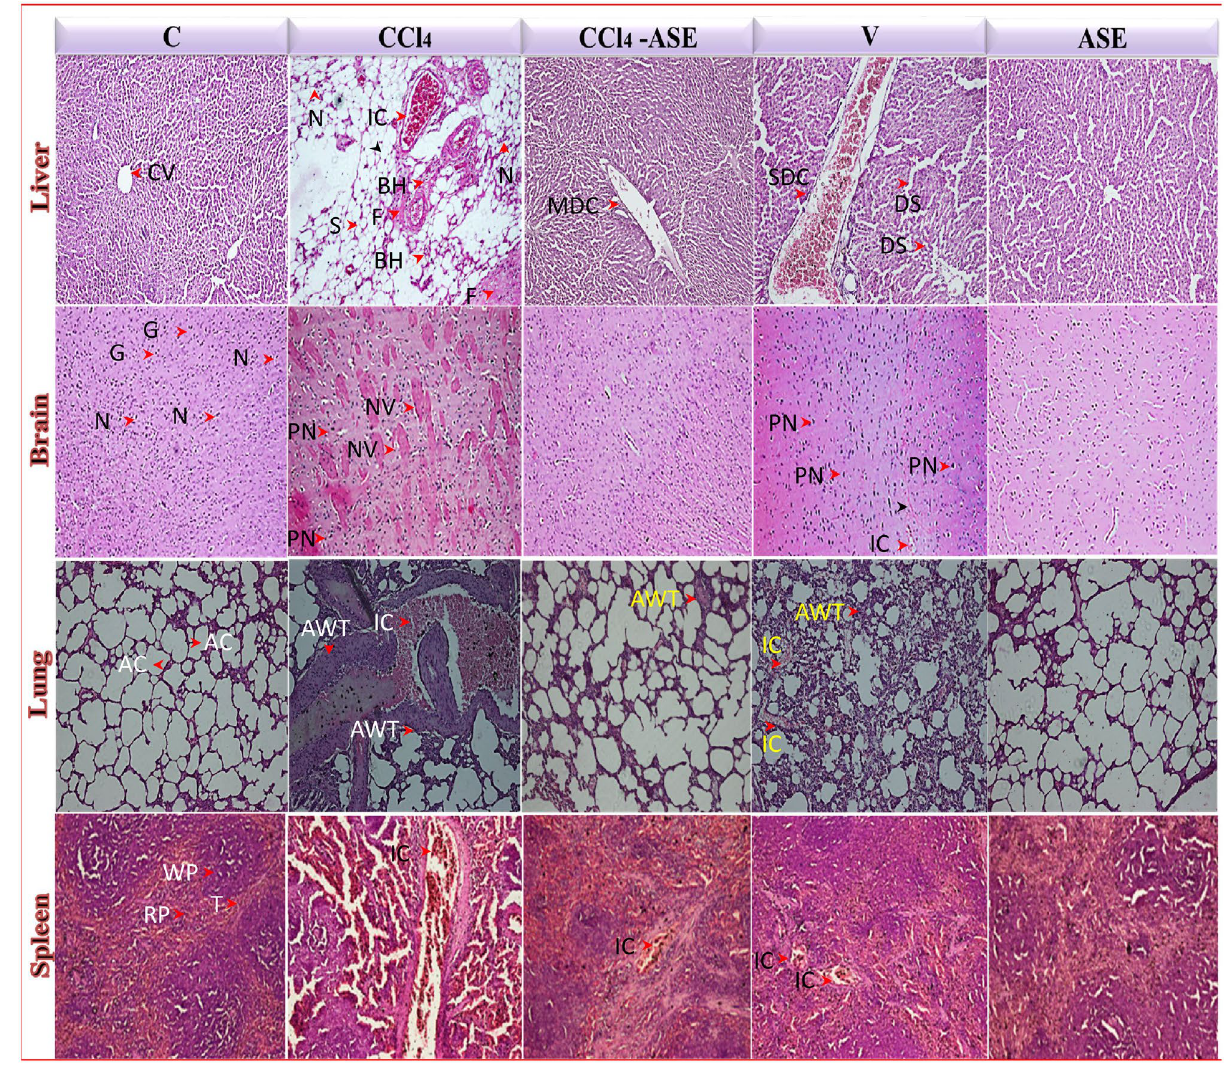
Figure 7. Photomicrographs (H&E stain, 20 ×) for liver, brain, lung, and spleen sections of the different studied groups revealed the ameliorating effects of ASE against the systemic toxicity induced by CCl 4 injection. AC alveolar cells, AWT : alveolar wall thickness, BH binucleated hepatocytes, CV central vein, DS dilation of sinusoidal cells, F fibrous bands, G glial cells, IC inflammatory cells, MDC mild dilation of central vein, N neurons, NV neurons with the vacuole, PN neurons with pyknotic nuclei, RP red pulp, SDC severe dilation of the central vein, S steatosis, T trabecula, WP white Regarding the brain, the control tissues showed normal architecture with normal glial cells and neurons. This normal morphology was changed after CCl 4 injection to severe damage with severe degeneration of neurons that was characterized by the appearance of pyknotic nuclei and vacuoles in the neuronal cells. Administration of ASE restored the architecture of the brain and relieved the CCl 4 toxicity. Injection of rats with olive oil (V group) caused mild degeneration of the neurons, which appeared with pyknotic nuclei and vacuoles in addi- tion to the accumulation of the inflammatory cells in their vicinity. All these features reflected the induction of necroinflammation in the brain tissue of rats in the V group, while the oral administration of ASE alone (ASE group) didn’t affect the normal morphology of the brain. The lung tissue in control rats had the normal appearance of the alveolar sacs and alveolar walls. Massive disruption was observed in its morphology after injection with CCl 4 , which is characterized by inflammatory cells influx with alveolar wall thickness and alveolar epithelium damage. Great amelioration in the lung morphology was observed following the administration of ASE (CCl 4 -ASE) compared to those in the CCl 4 group. Hence, the lung tissue seemed normal with only mild thickness in the alveolar septae. In contrast, thickness in the alveolar septae with infiltration of the inflammatory cells and narrowing of the alveolar air spaces have appeared in the lung tissue sections of the animals in the V group. While no abnormal features were observed in the morphology of lung tissue in the rats of the ASE group.